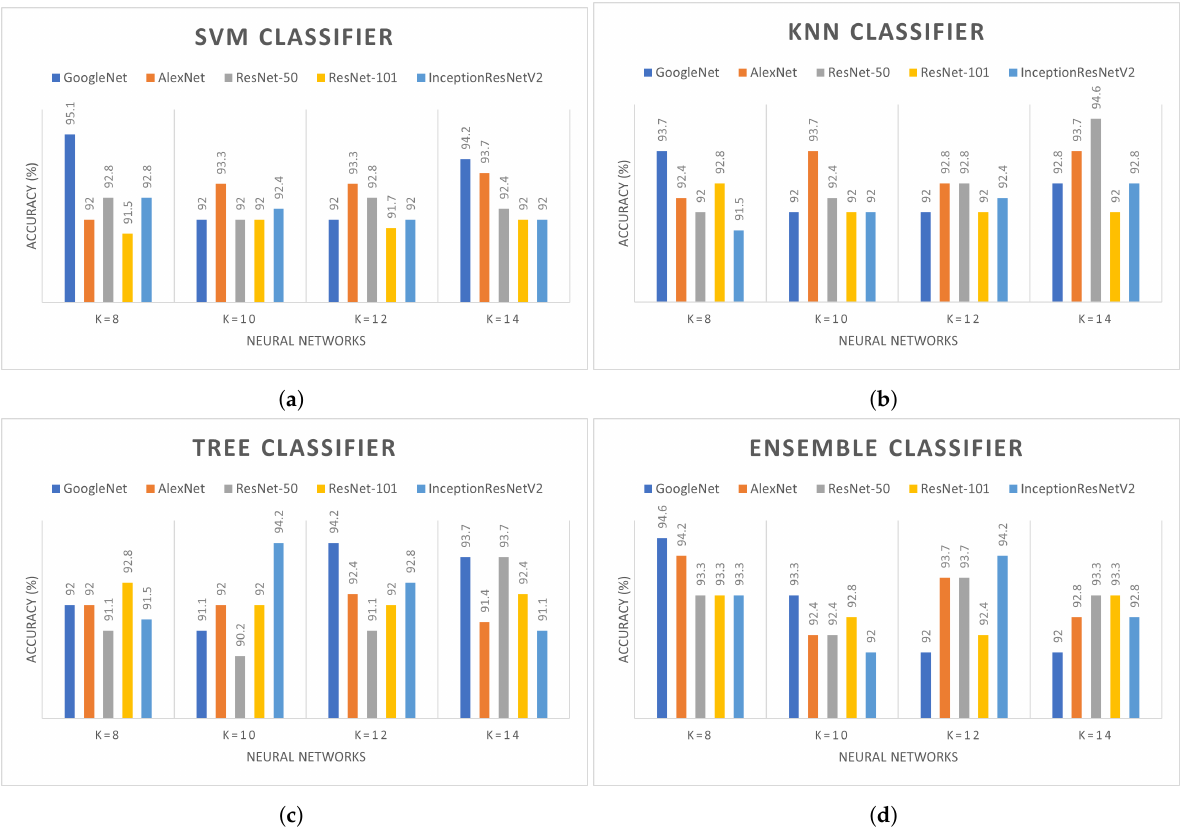
Figure 6. Comparison of different deep learning with ( a ) SVM, ( b ) KNN, ( c )Tree, ( d ) Ensemble classi-